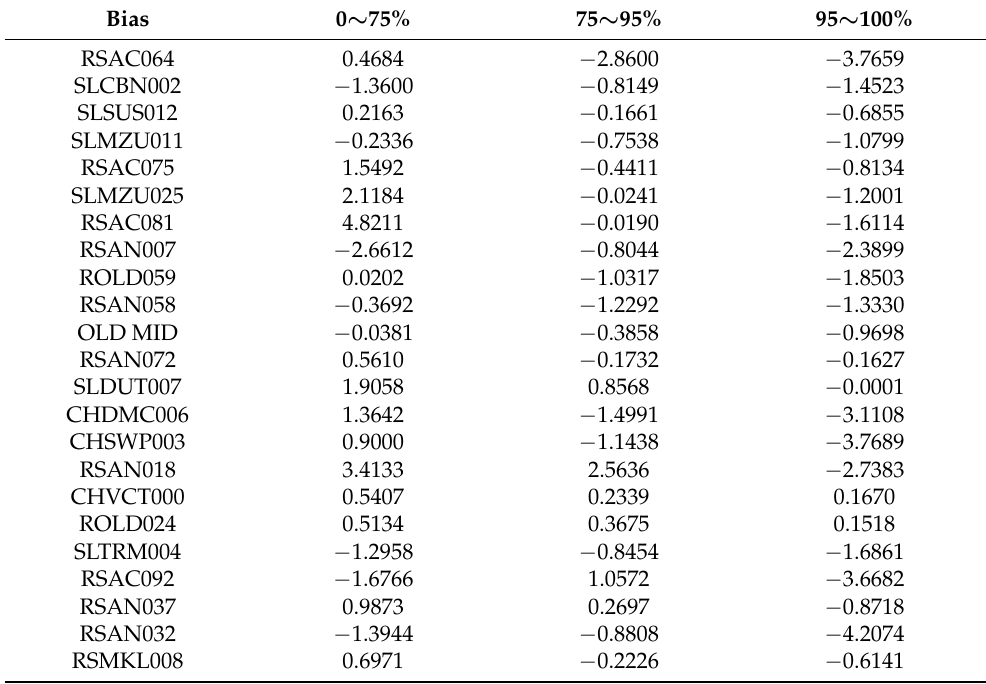
Table A3. Station-wise percent bias results of Res-LSTM at hourly time step with daily inputs.